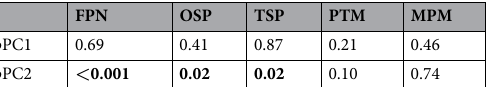
Table 3. Significance of the slope (i.e. different from 0) of the relationship between pPC1, pPC2 and the average number of femoral pores (FPN), one-gland secretion production (OSP), total secretion production (TSP), foraging variables PTM and MPM. Bold indicate statistical significance. Slope for FPN = 0.14. Slope for OSP = 0.21. Slope for TSP =